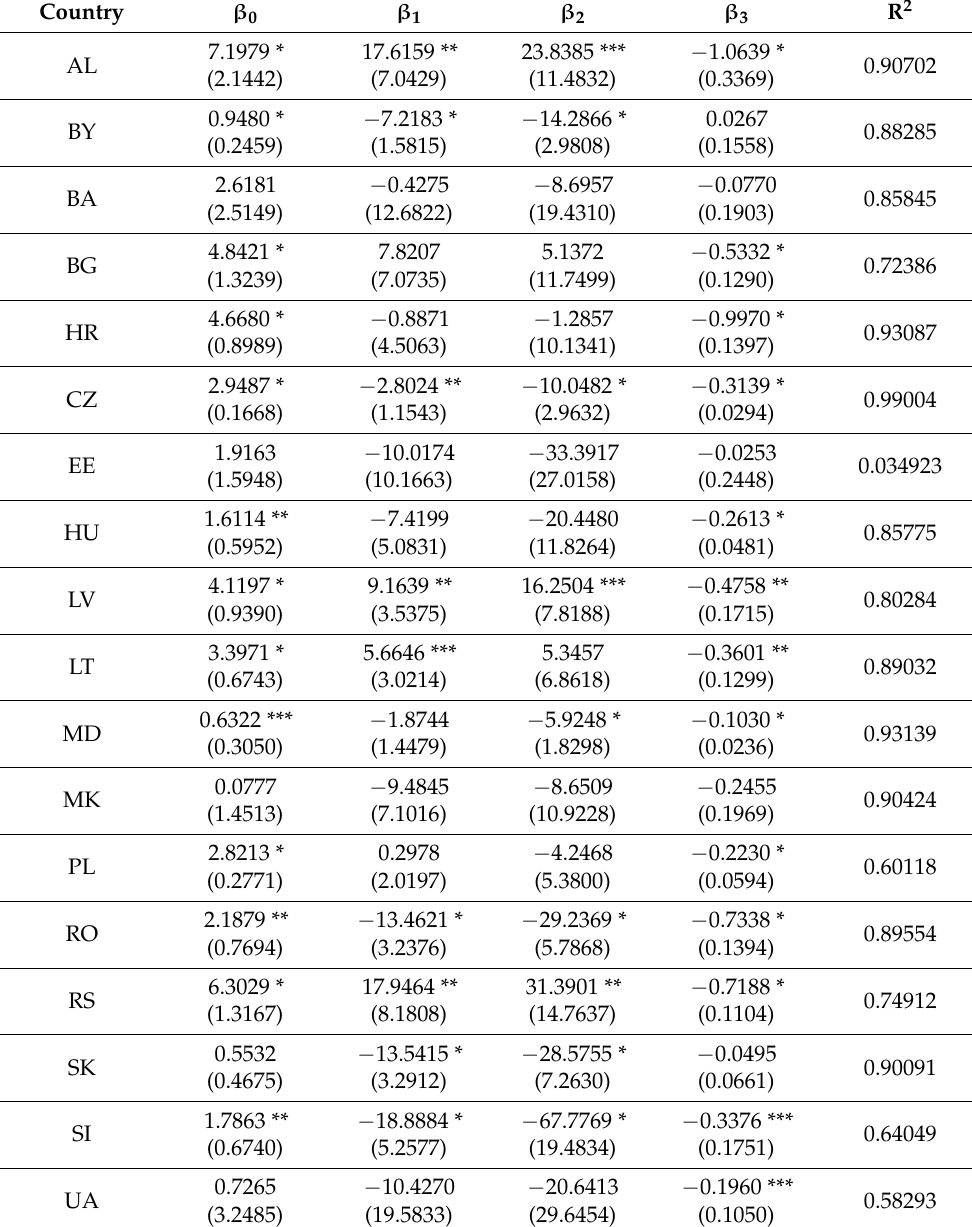
Table 9. Estimation of model parameters for independent variables HDI index and